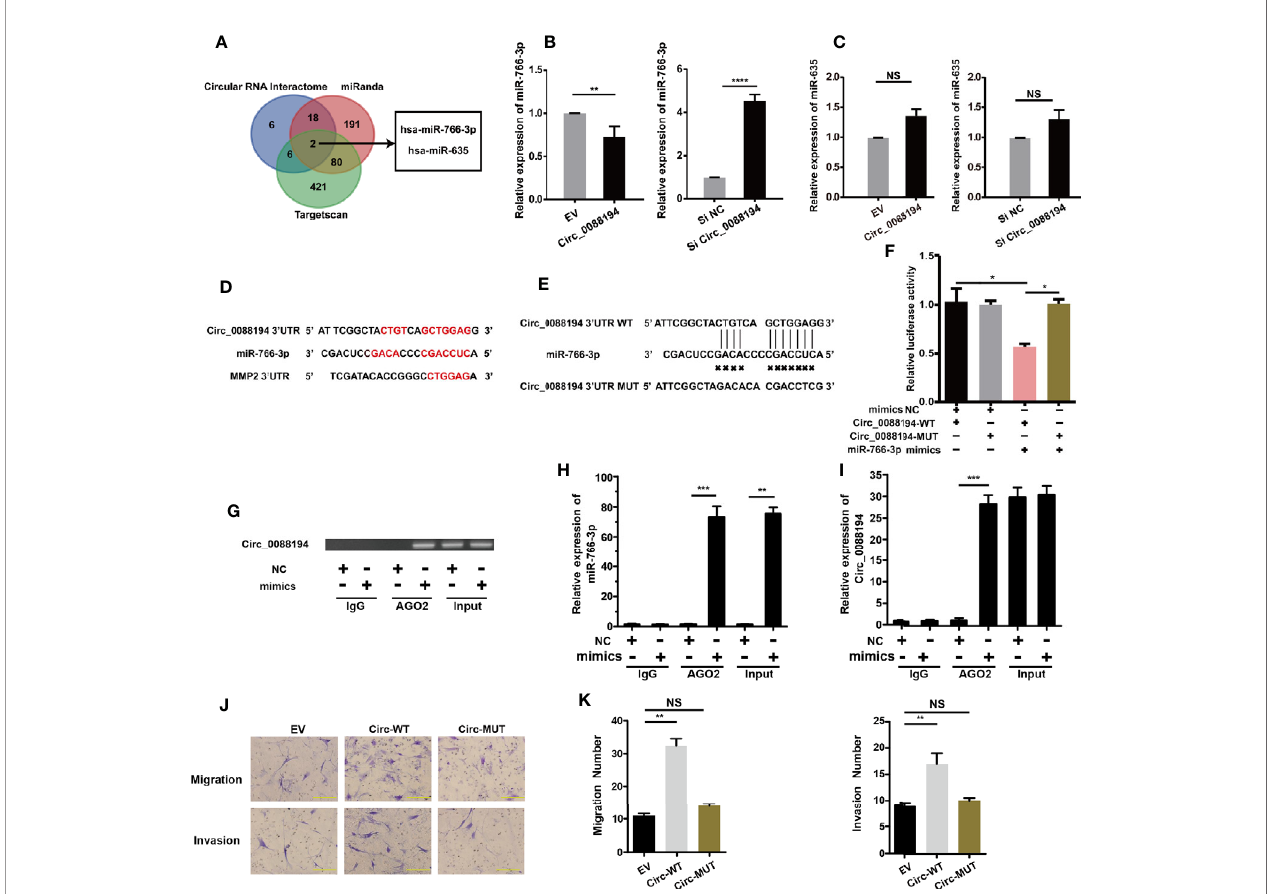
FIGURE 4 | Circ_0088194 act as sponge of miR-766-3p in RA-FLSs. (A) Schematic illustration showing the identi fi cation of two miRNAs, hsa-miR-766-3p and hsa- miR-635, predicted from three available databases (miRanda, circular RNA interactome, and Targetscan). (B, C) QRT-PCR determination of the expression of miR- 766-3p (B) and miR-635 (C) in RA-FLSs. The cells were transfected with adenovirus expressing Circ_0088194 or Circ_0088194#1 siRNA. (D) The miR-766-3p MREs in the sequences of Circ_0088194 and MMP2 as identi fi ed using bioinformatic analysis. (E) Wild-type (WT) or mutant (MUT) miR-766-3p target sequences of Circ_0088194. (F) The miR-766-3p mimics reduced the luciferase activities of WT not MUT Circ_0088194 reporter genes, as assessed using dual-luciferase reporter assays. (G) RA-FLSs were transfected with the miR-766-3p mimics or the negative control. Anti-AGO2 RIP was used to investigate AGO2 binding to Circ_0088194 and miR-766-3p; IgG was used as a negative control. (H, I) The expression levels of Circ_0088194 and miR-766-3p, as detected using qRT-PCR. (J, K) The migratory and invasive activities of RA-FLSs were evaluated by Transwell migration and Matrigel invasion assays. RA-FLSs were transfected with the adenovirus encoding Circ_0088194 or the adenovirus encoding Circ_0088194 with mutated miR-766-3p binding sites. Scale bar, 500 µm. Data are shown as mean ± SD. NS, not signi fi cant. *indicates p < 0.05, **indicates p < 0.01, ***indicates p < 0.001, and ****indicates p <